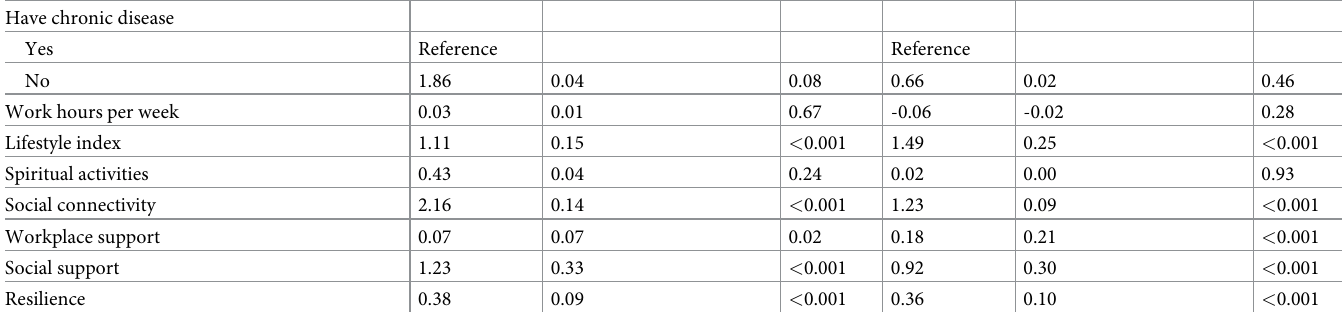
for physical domain, 59.72 vs 64.15 for psychological domain, 64.23 vs 65.98 for social domain, and 58.77 vs 63.63 environmental domain respectively). Previous studies have shown that nurses have higher rates of anxiety and depression compared to doctors [40] and these psycho- logical factors were predictors of lower QoL among HCWs [27]. These observations might